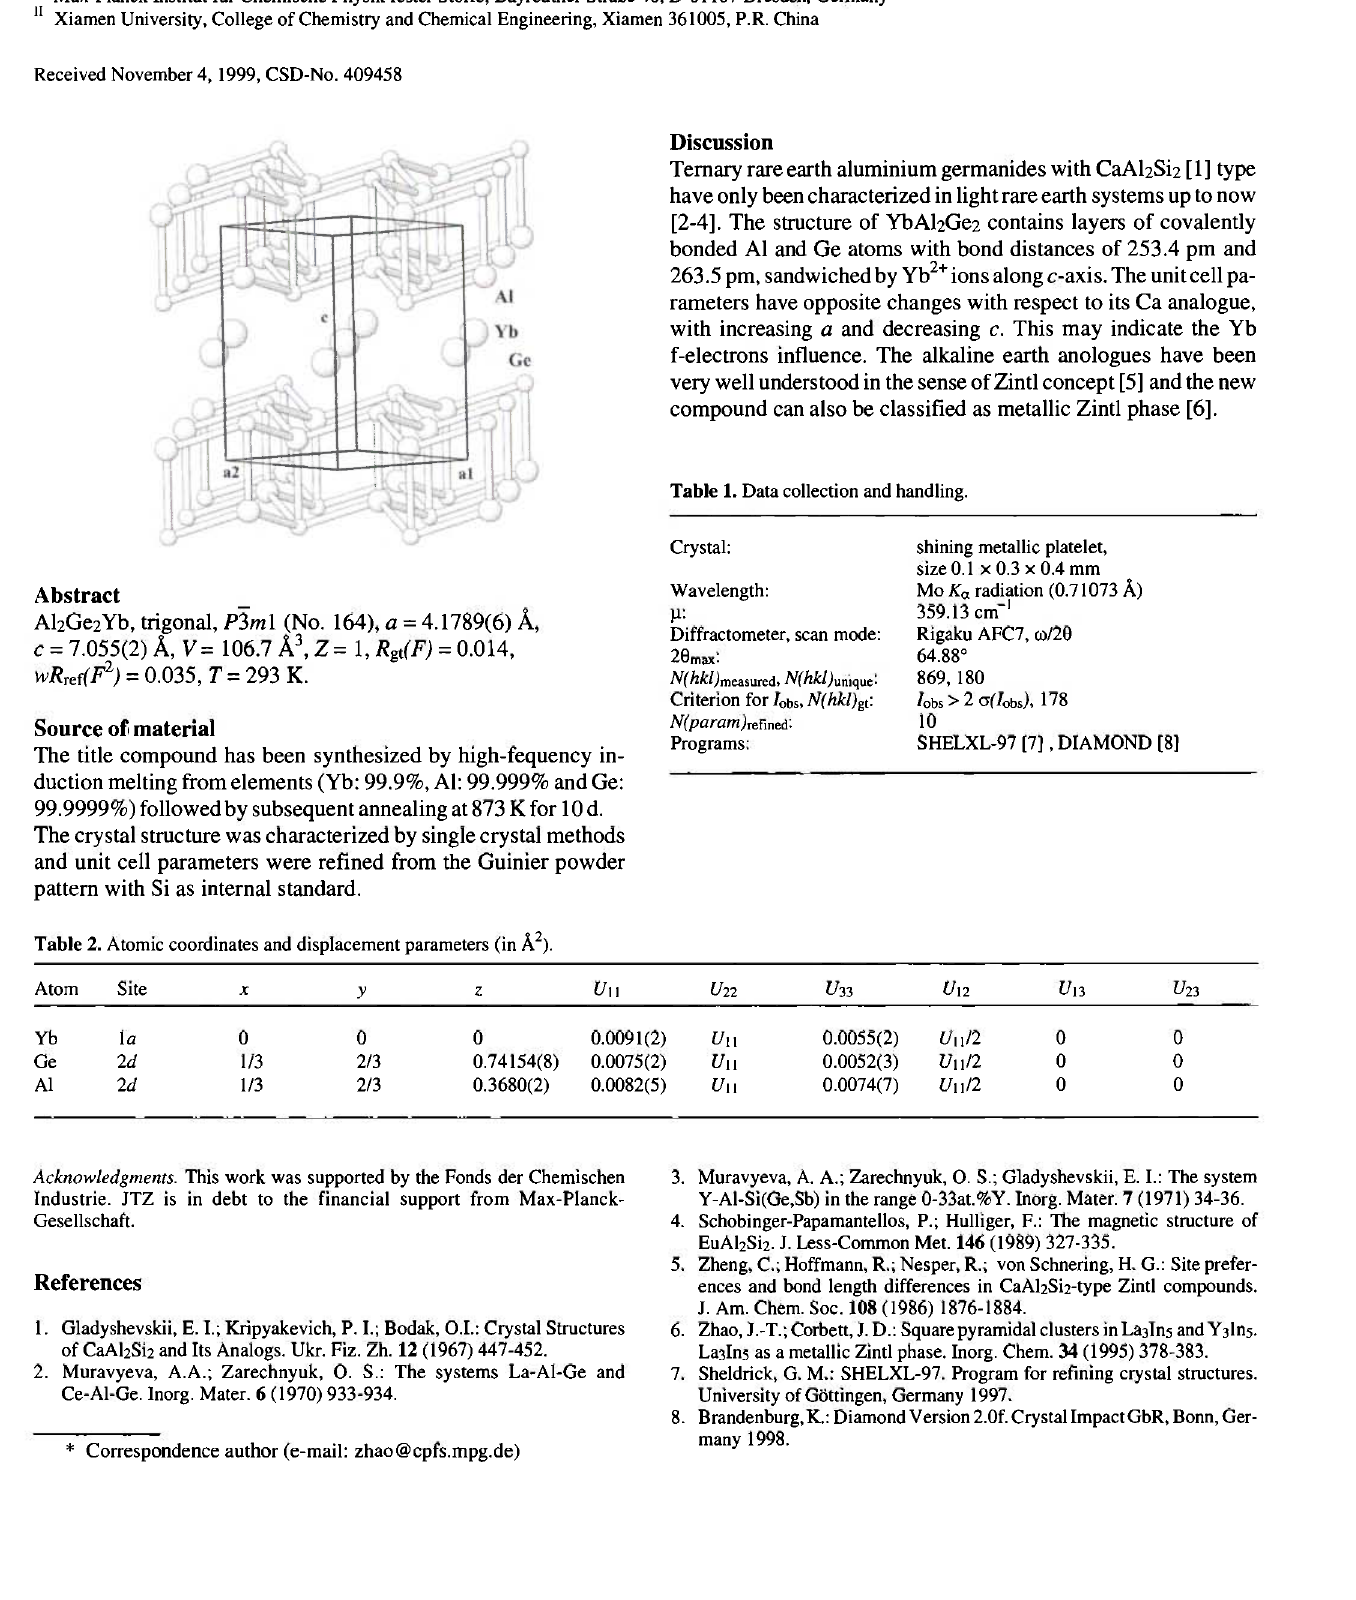
Table 1. Data collection and handling.